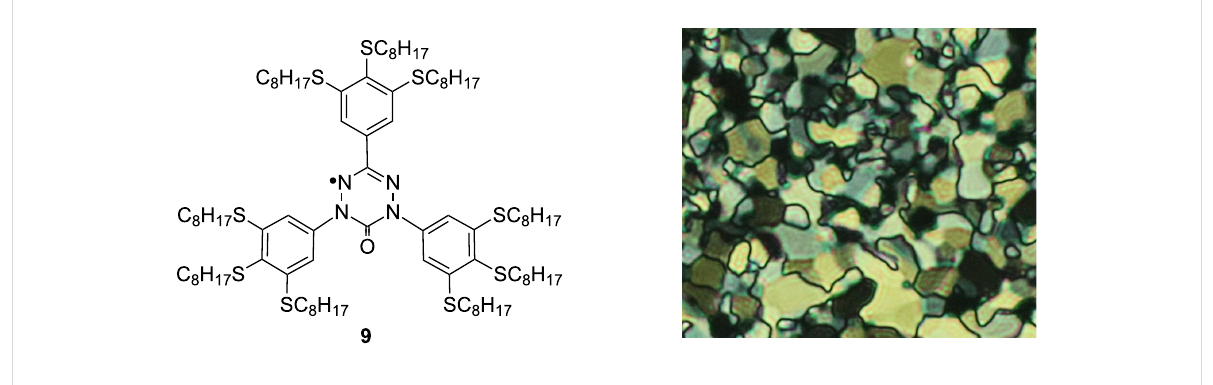
Figure 4: The structure of verdazyl radical 9 and a texture of the Col r phase.